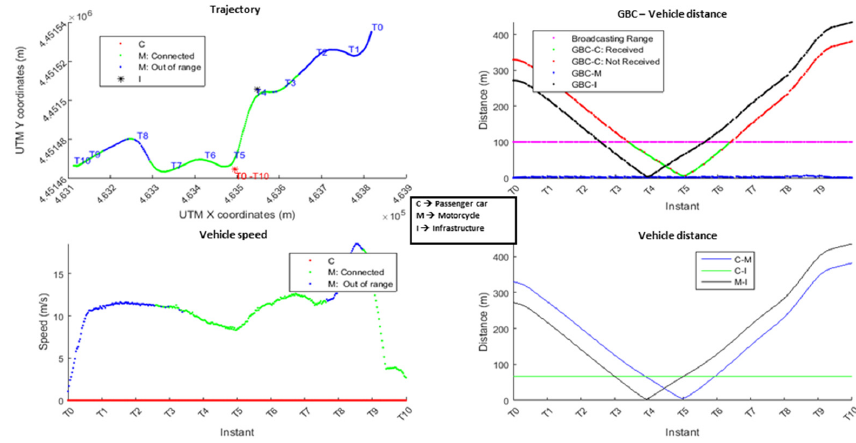
Figure 10. Results of Test 2 with RSU.